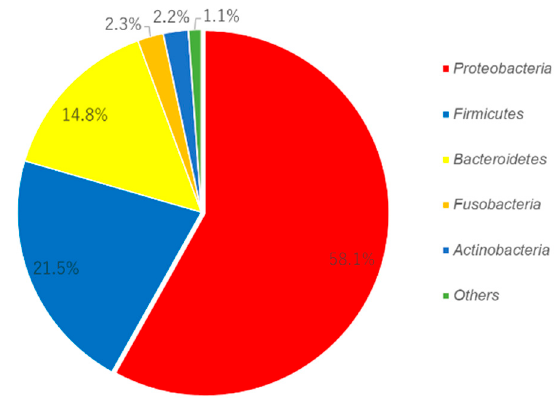
Figure 1. Abundance of the oral microbiome of the 13 subjects at the phylum level.